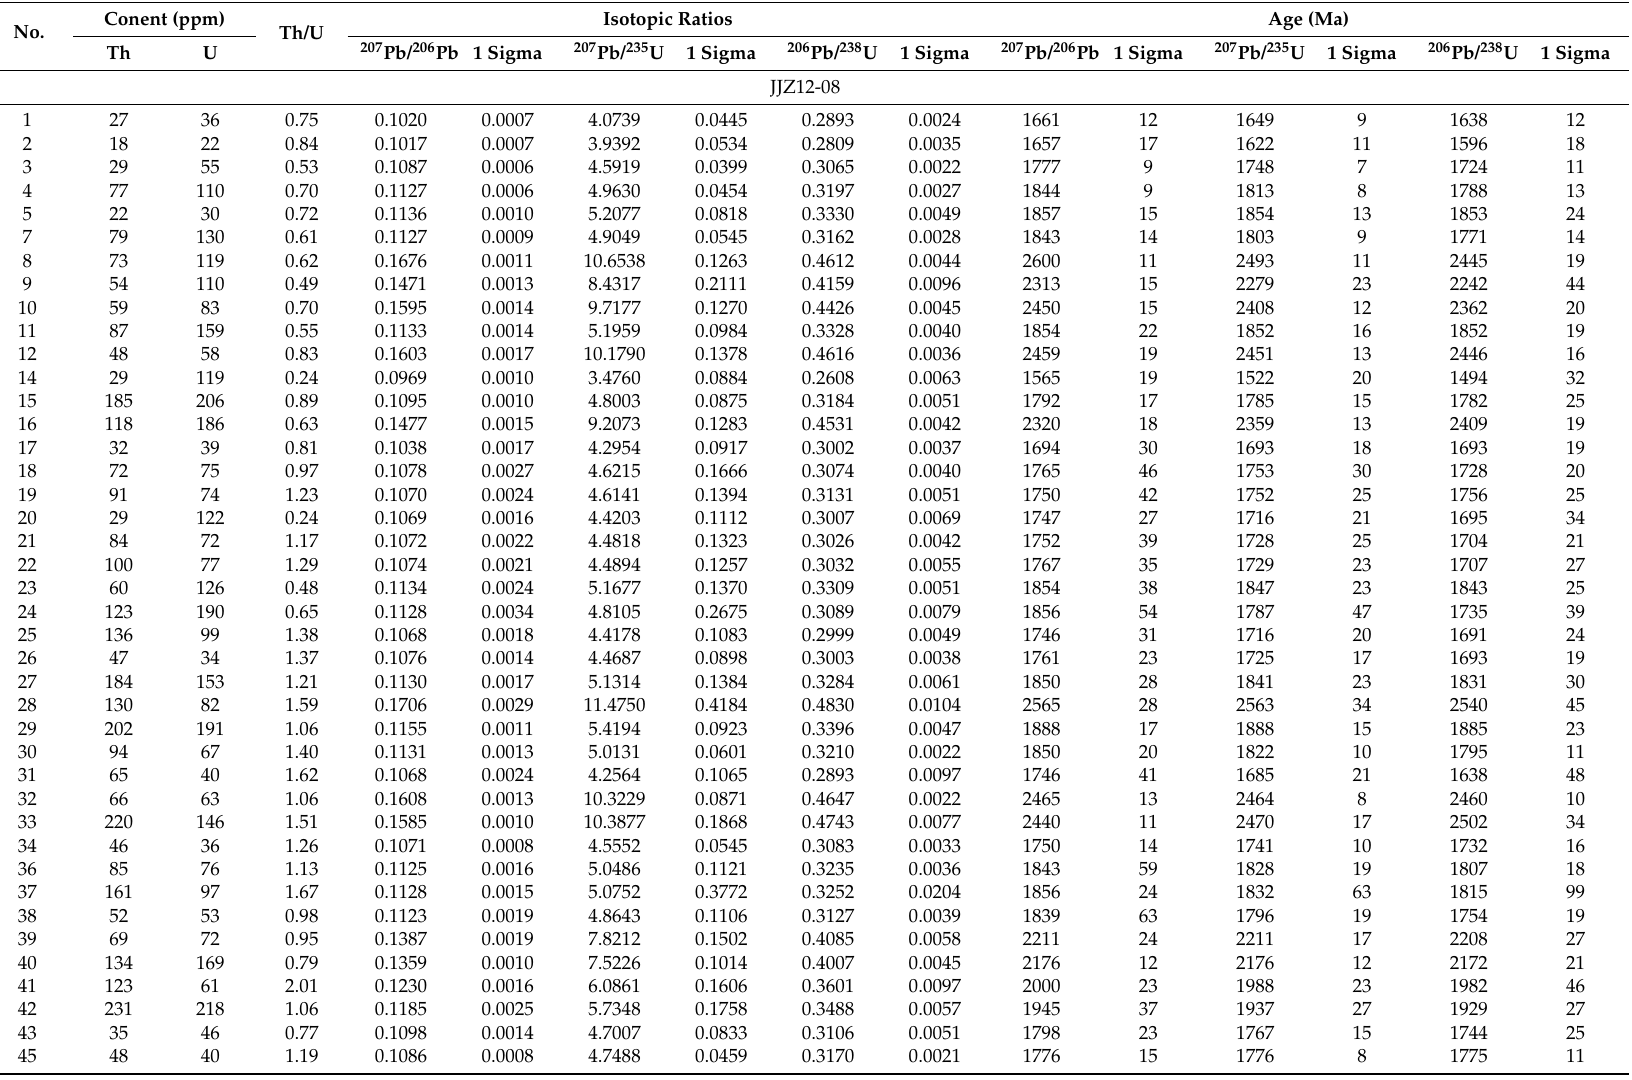
Table 2. In situ Lu-Hf isotopes analytical data for detrital zircons from the Chuanlinggou